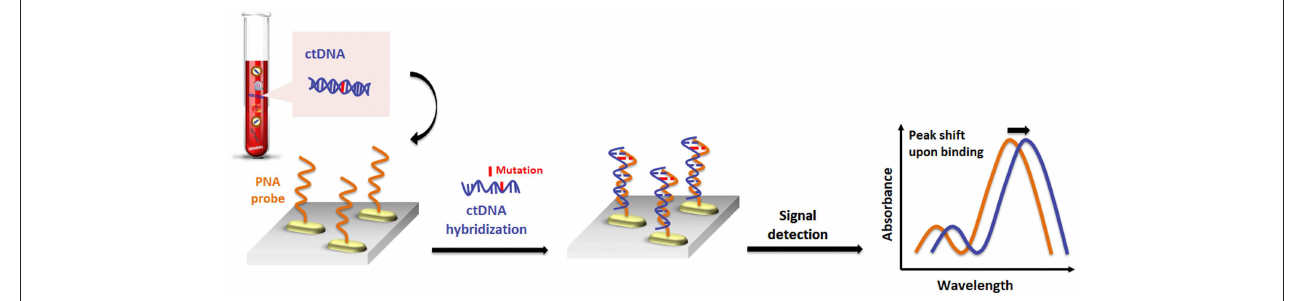
FIGURE 4 | Pictorial description for the sequence-specific detection of circulating tumor DNA (ctDNA) point mutations based on PNA and gold